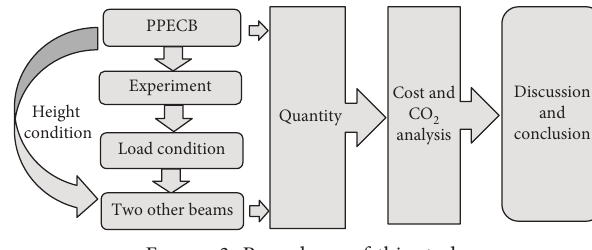
Figure 3: Procedures of this